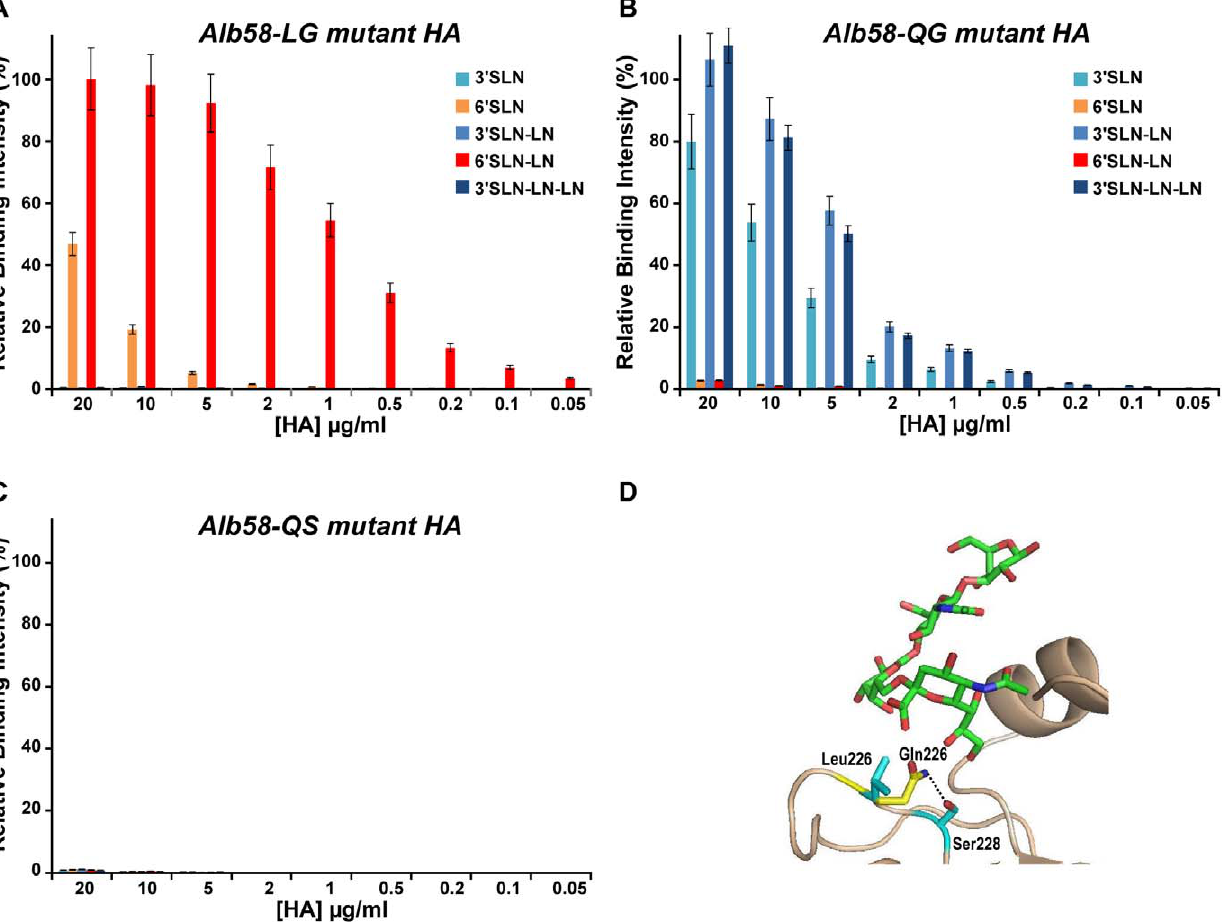
Figure 2. Glycan receptor-binding specificity of mutant forms of Alb58 HA. Shown in A-C is the dose-dependent glycan array binding of Alb58-LG , Alb58-QG and Alb58-QS mutants respectively. A single amino acid change from Ser228 R Gly ( Alb58-LG mutant) leads to a loss of avian receptor binding observed in Alb58 HA. An additional Leu226 R Gln mutation (on Alb58-LG ) completely transforms the binding specificity by making the Alb58-QG mutant bind predominantly to avian receptors. Alb58-QS mutant shows loss of both avian and human receptor binding. D shows homology based structural model of Alb58-QS mutant (RBS part is shown as a cartoon in beige ) with the human receptor. Both the Leu226 and Gln226 side chains are marked. The Gln226 in the mutant is positioned to interact with Ser228 hence making the 226 position less favorable for contacts with both human and avian receptors.